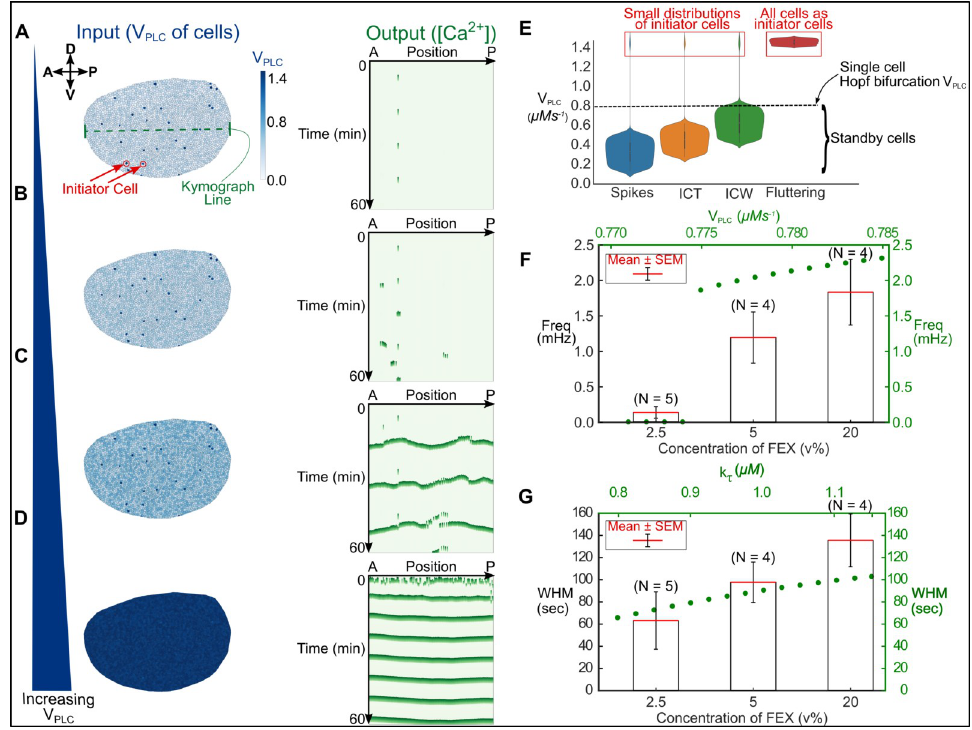
Fig 2. The level of hormonal stimulation governs the spatial extent of intercellular Ca 2+ communication. (A-D) Computer simulations recapitulating the key classes of multicellular Ca 2+ activity observed in vivo and ex vivo. (A) When the majority of cells have V PLC values below the Hopf bifurcation threshold ( left ), single-cell Ca 2+ spikes are seen ( right ). Initiator cells (red arrows) are cells with V PLC values set between 1.4 and 1.5 in the simulation. A line through the A/P direction (green) demonstrates where the kymograph line is drawn that produces the simulated tissue’s corresponding kymograph. (B) Intercellular Ca 2+ transients are observed ( right ) as the distribution of V PLC in cells is increased ( left ). (C) A further increase in V PLC ( left ) results in the emergence of periodic intercellular Ca 2+ waves ( right ). (D) “Fluttering” occurs ( right ) when V PLC levels in all of the cells in the disc is above Hopf bifurcation ( left ). (E) Quantification of V PLC distribution in the initiator and the standby cells for each of the classes of Ca 2+ signaling activity. The first three Ca 2+ signaling classes have a small distribution of initiator cells (red box) that are necessary for signal initiation. The dashed line indicates the threshold of the V PLC parameter that permits Ca 2+ oscillations. (F-G) The single-cell version of our model predicts that the frequency and width at half maximum (WHM) of Ca 2+ oscillations is altered by varying V PLC and k τ . This prediction matches the WHM of Ca 2+ activity observed in ex vivo discs cultured with variable concentrations of fly extract. Error bars are reported as standard error of the means (SEM).